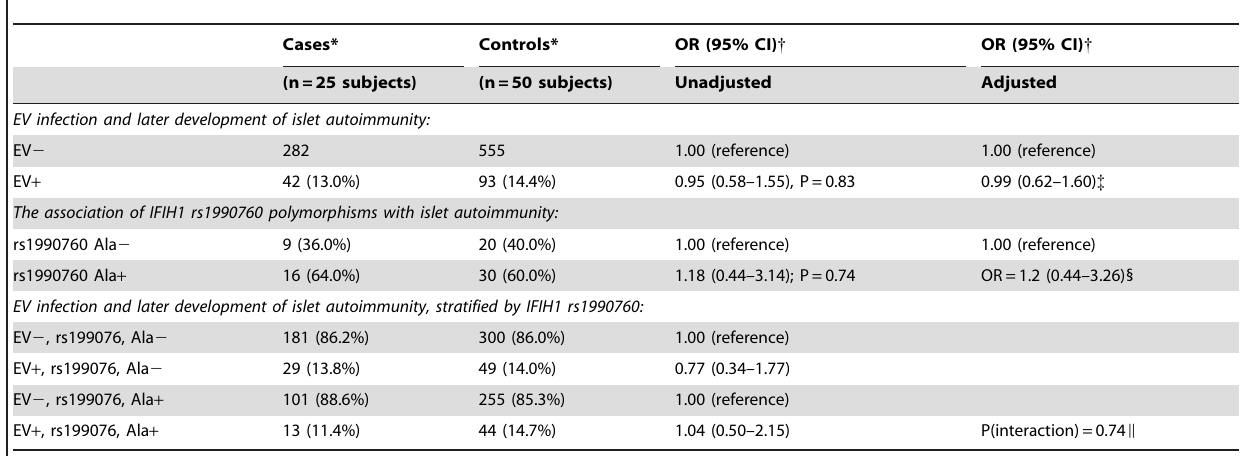
Table 2. Frequency of enterovirus RNA in faecal samples prior to islet autoimmunity and matched controls and influence of IFIH1